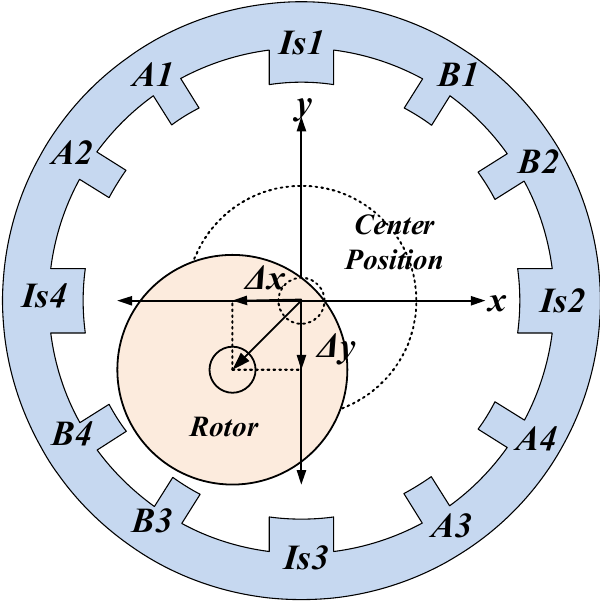
Figure 17. Simple eccentric view of the rotor in air gap.